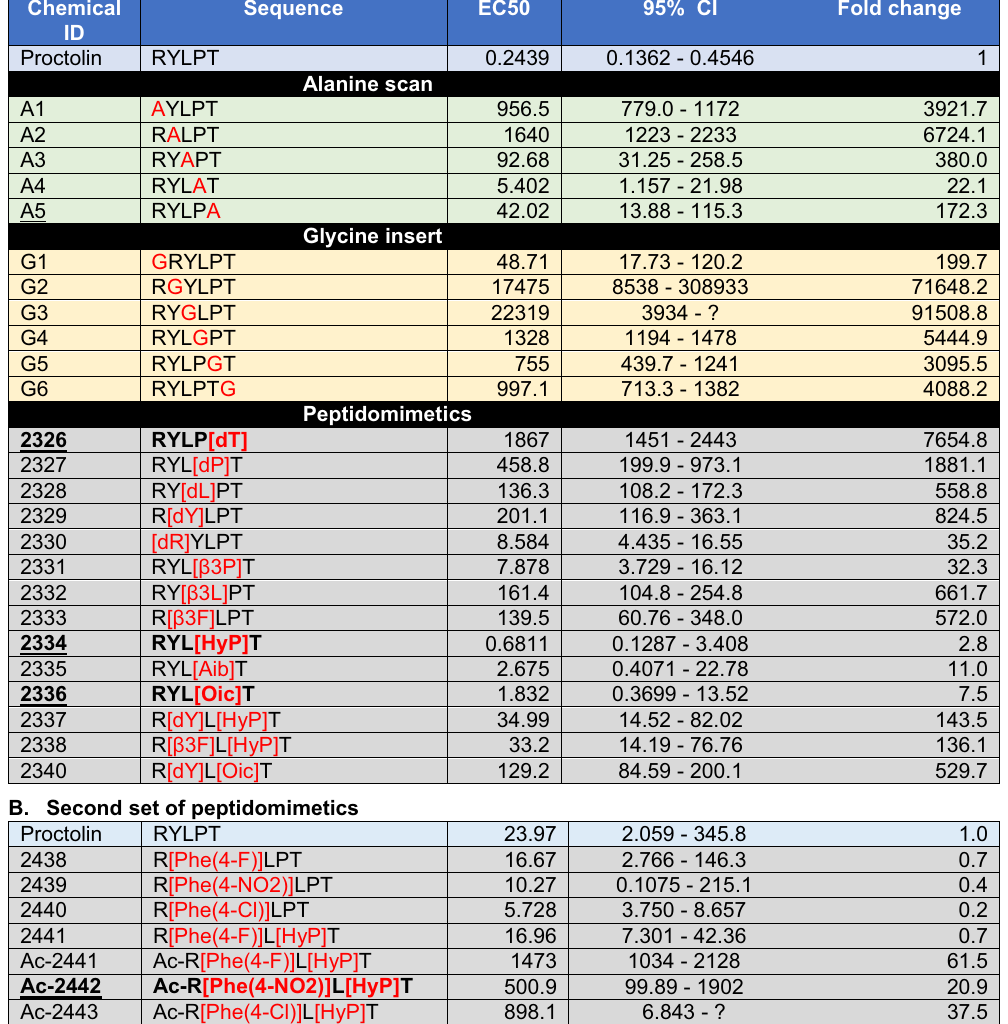
Table 1. Activities of proctolin and its mimetics on the Varroa mite proctolin receptor. The modified amino acids are in red in the amino acid sequences. Bold and underlined peptidomimetics are the ones further studied in feeding assay. [d] is for D- amino acid, [β3] is for beta -3 amino acids, [Hyp] is for hydroxy proline, [Aib] is for 2-amino butyric acid, and [Oic] is for octahydroindole-2-carboxylic acid, and [Phe-4] is for modified phenylalanine at the 4 position. Note that the second set of peptidomimetics were tested on the cells selected for stable expressions of the receptor showing significantly lower activity to proctolin and to other analogues than those in the first set using the cells with transient expression of the